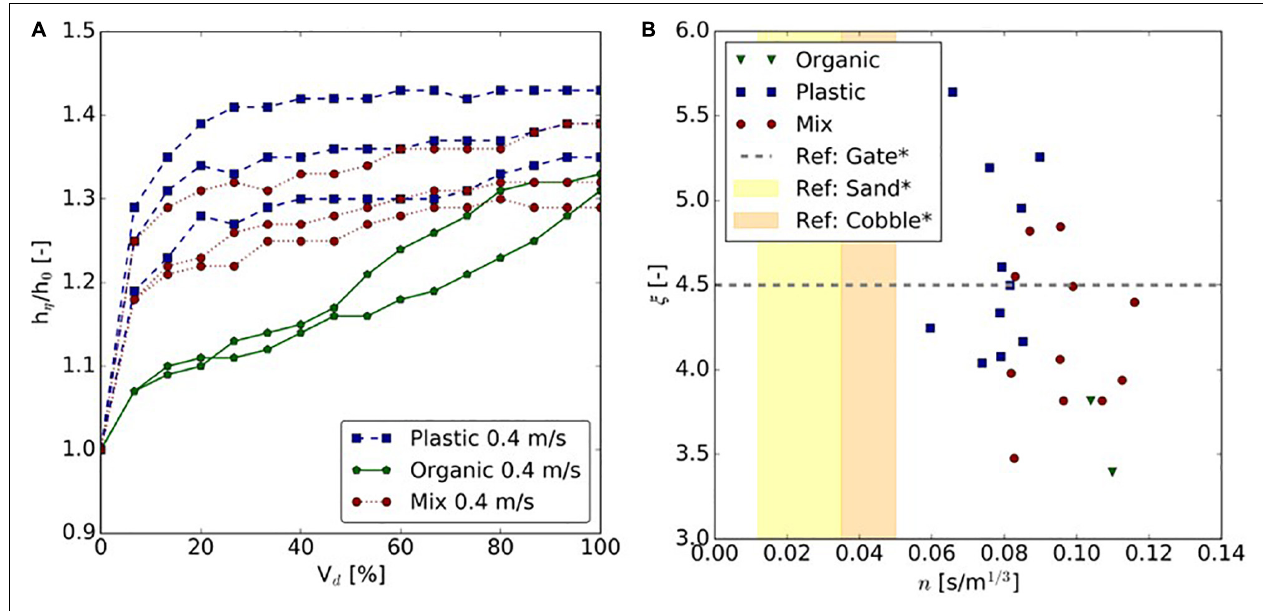
FIGURE 3 | (A) Initial debris accumulation at trash rack and (B) carpet formation for experiment 4 with M = 0.8 kg and v 0 = 0.4 m/s.